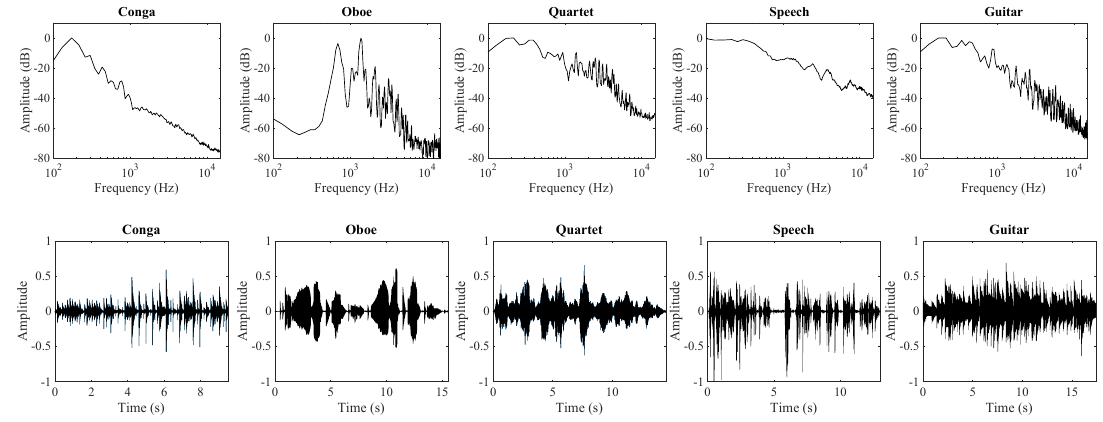
Figure 2. Long term average spectra and waveforms of test stimuli used for Experiment One. 140 The following eight experimental conditions were applied to the sources to create test stimuli. For the VLT cases, the attenuation was only applied to the direct sound in the height layer, with the ICTDs of 0 and 1